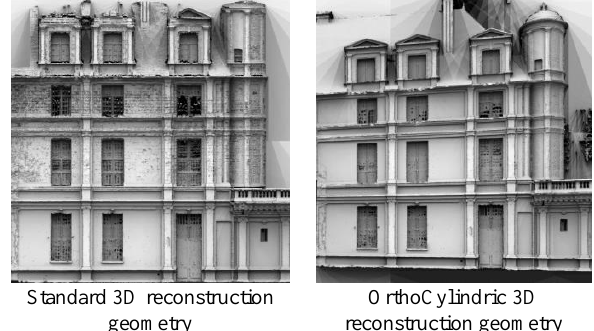
Figure 13: 3D reconstruction differences between standard cartographic and orthocylindric geometry (Shaded relief images)